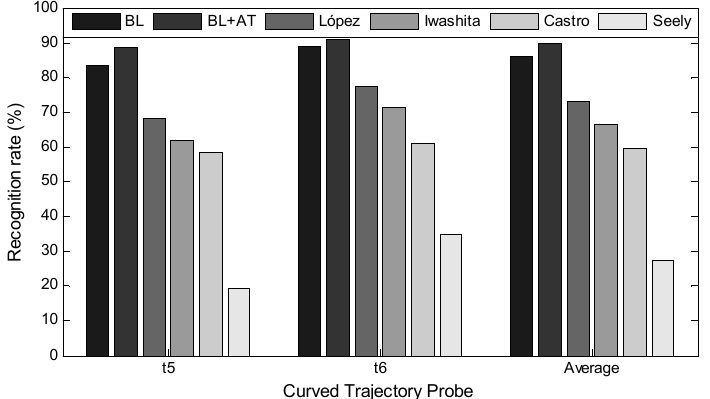
Figure 14. Gait recognition rates comparison on KY4D gait dataset.